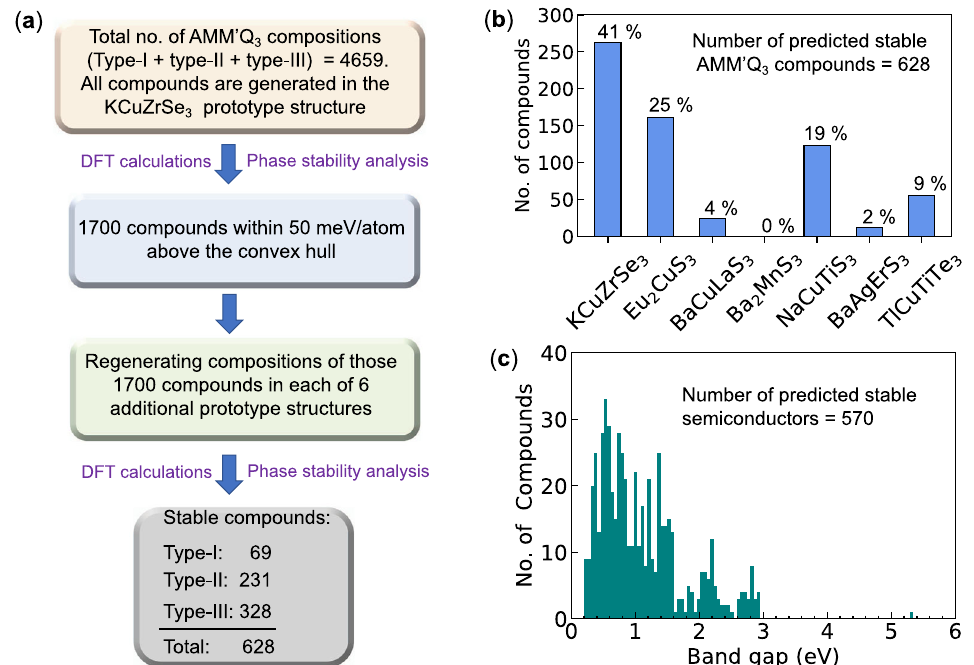
Fig. 3 A brief work fl ow and summary of high-throughout DFT calculations. a A schematic fl owchart of the HT-DFT calculations for the discovery of new AMM ′ Q 3 compounds. b The distribution of 628 predicted stable compounds in the seven structure types. c 570 out of 628 compounds possess fi nite band gaps. Histogram plot for the DFT-calculated band gaps of these 570